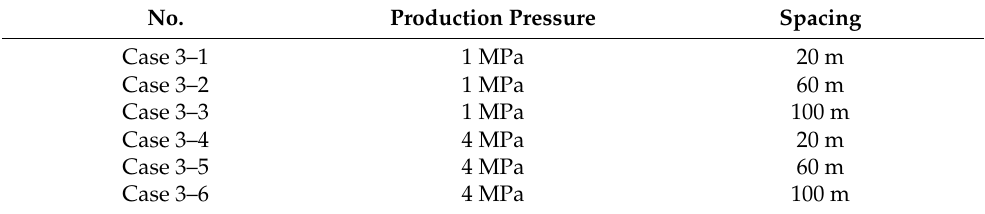
Table 5. Main production parameters for the clustered depressurization cases.